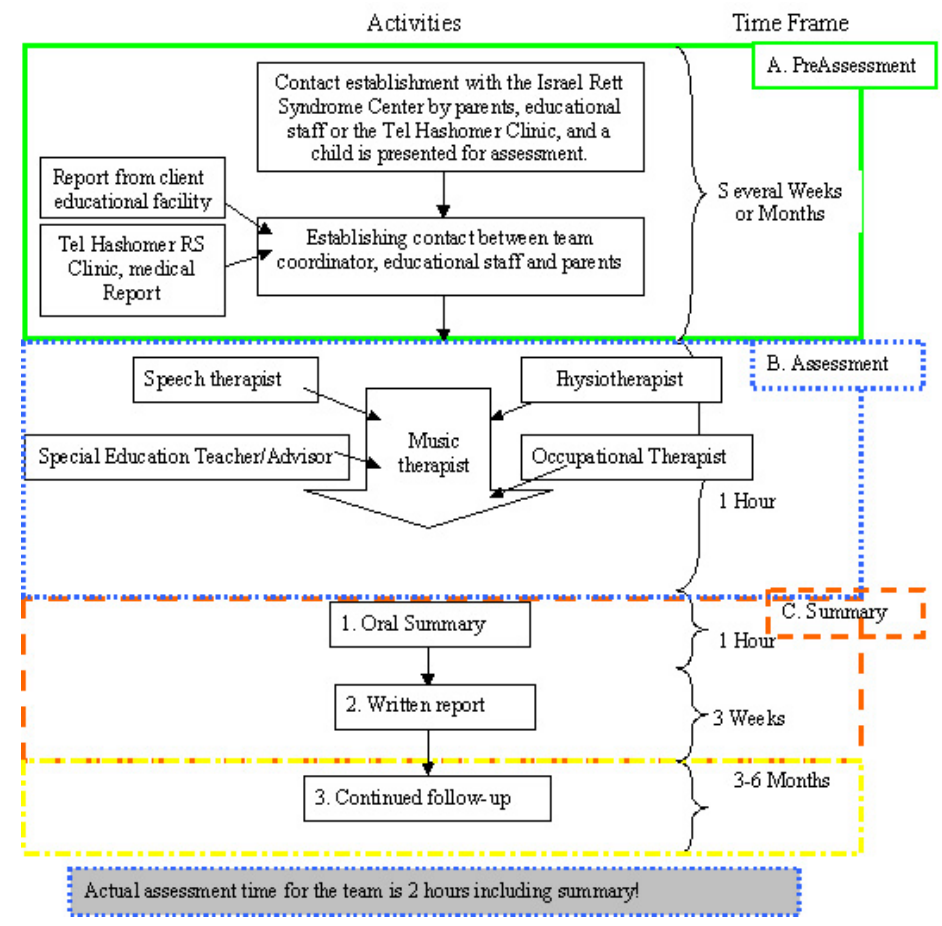
FIGURE 1. Chronological flowchart for performance of assessment for individuals with